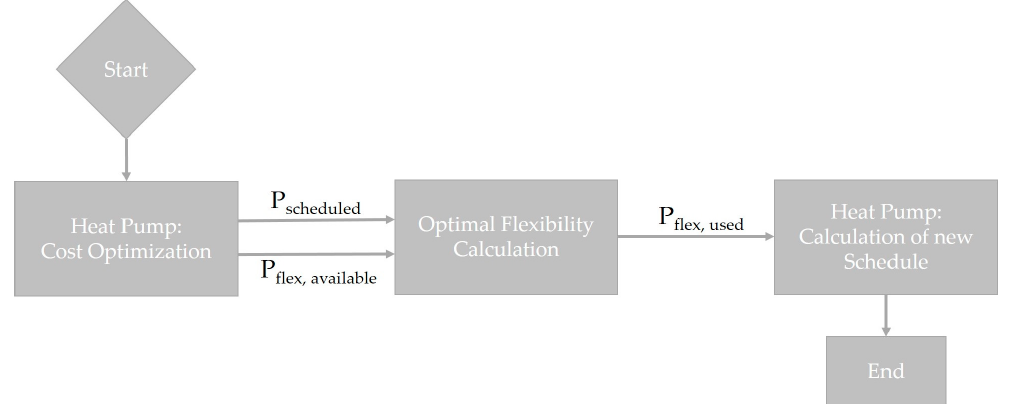
Figure 1. Flow diagram of the Optimal Flexibility Calculation framework.